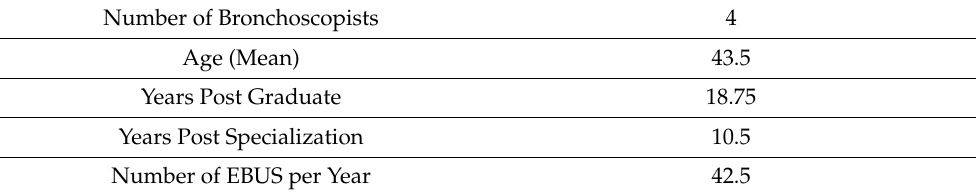
Table 2. Demographics of experienced EBUS bronchoscopists participating in EUS-B FNA